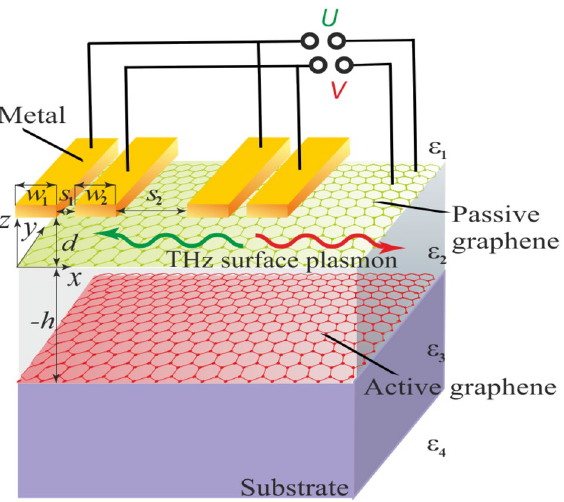
Figure 1. Schematic view of the structure under consideration (two unit cells of the periodic structure are